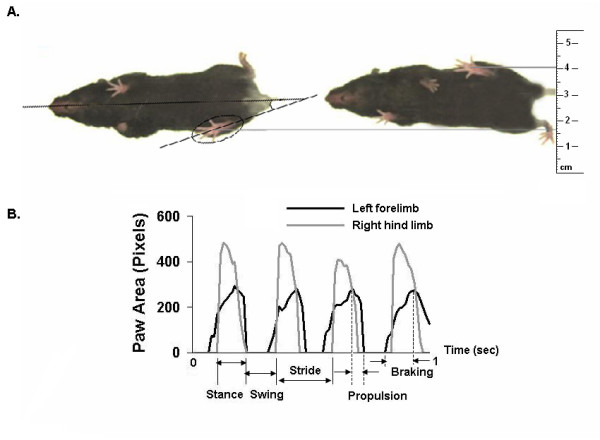
Ventral view of walking saline-treated mouse. A. Two images depicting the ventral view of a saline-treated C57BL/6J mouse on a transparent treadmill belt walking at a speed of 34 cm/s. The example on the left depicts full stance for the right hind limb, and the example on the right depicts sequential full stance for the left hind limb. Cartesian coordinates are used to determine stance width and paw placement angles for the forelimbs and hind limbs. B. Representative gait signals of the left forelimb and right hind limb of a saline-treated C57BL/6J mouse walking at a speed of 34 cm/s. Duration of stride, stance, and swing are indicated for the right hind limb. Duration of braking and propulsion are indicated for the left fore limb.